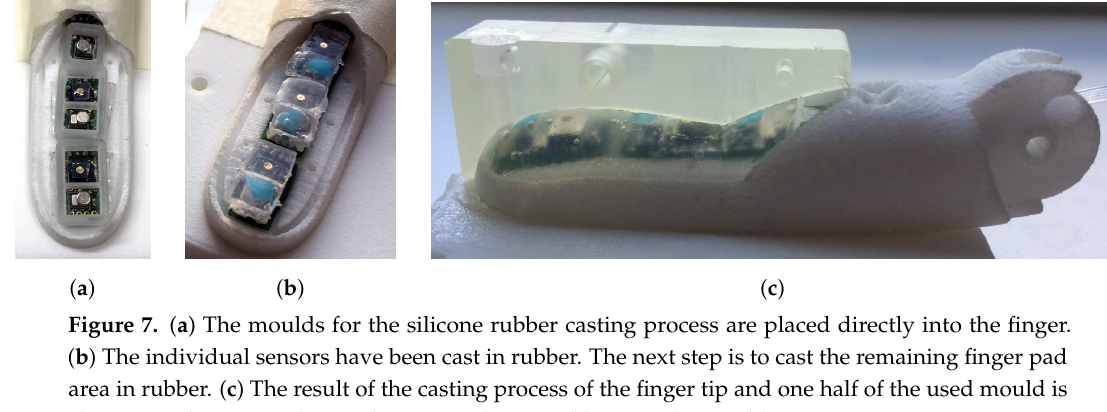
Figure 7. ( a ) The moulds for the silicone rubber casting process are placed directly into the finger. ( b ) The individual sensors have been cast in rubber. The next step is to cast the remaining finger pad area in rubber. ( c ) The result of the casting process of the finger tip and one half of the used mould is shown. A silicone canal is used to inject silicone rubber into the